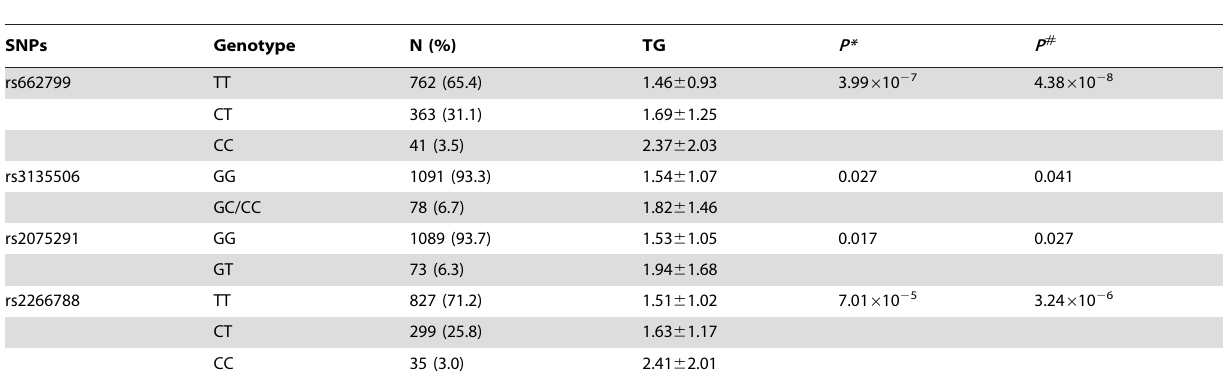
Table 2. Association between the SNPs in APOA5 and plasma TG levels in the general Uyghur population.